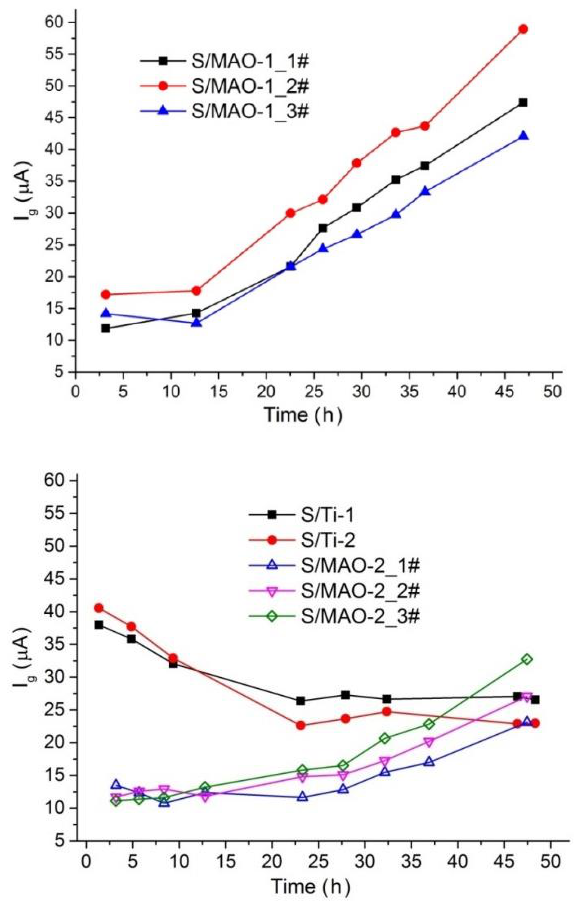
Figure 14. Change curves of galvanic current of S/MAO-1, S/MAO-2, and S/TA2 couples with time in 3.5% NaCl solution.